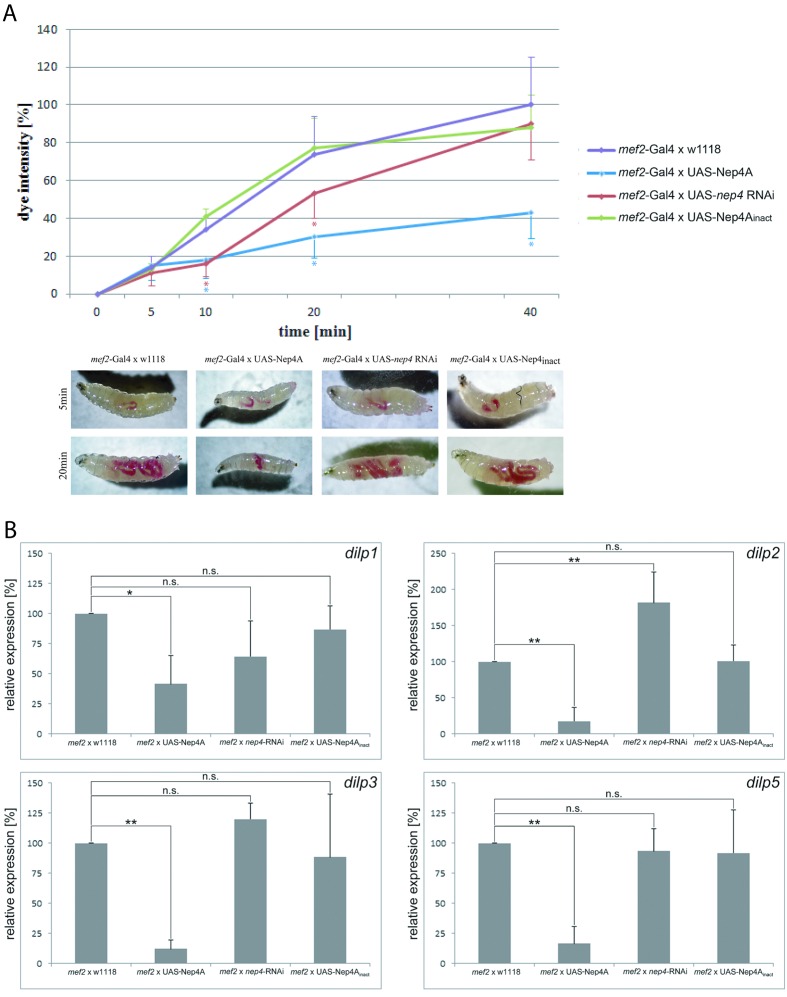
Muscle-specific modulation of nep4 expression affects food intake and dilp expression in transgenic third instar larvae.(A) The genotype-specific rates of food intake are depicted as percentages (%) relative to the intake in control specimens (mef2-Gal4 x w1118) after 40 min of feeding, which was set to 100%. While nep4 knockdown animals (mef2-Gal4 x UAS-nep4 RNAi) exhibited reduced food intake after 10 and 20 min of feeding, Nep4A overexpression animals (mef2-Gal4 x UAS-Nep4A) were characterized by reduced intake throughout the whole measurement (up to 40 min). Animals overexpressing catalytically inactive Nep4A (mef2-Gal4 x UAS-Nep4Ainact) did not exhibit any significant changes in food intake, when compared to controls. Values represent the mean (± s.d.) of at least six independent biological replicates. Asterisks indicate statistically significant deviations from controls (*p<0.05, one-way ANOVA with pairwise comparisons). The lower panel depicts representative images of the genotype-specific food intake at the indicated time points. (B) Changes in the expression of selected dilp genes are presented as percentages (%) relative to expression in control specimens (mef2-Gal4 x w1118), which was set to 100%. Muscle-specific overexpression of Nep4A (mef2 x UAS-Nep4A) reduced the expression of every dilp gene analyzed, while nep4 knockdown in the same tissue (mef2 x nep4-RNAi) resulted in upregulation of dilp2. Animals overexpressing catalytically inactive Nep4A (mef2 x UAS-Nep4Ainact) did not exhibit any significant changes in dilp expression, when compared to controls. Values represent the mean (+ s.d.) of at least three independent biological replicates, each consisting of at least three technical replicates. Asterisks indicate statistical significance (*p<0.1; **p<0.05, one-way ANOVA with pairwise comparisons); n.s. indicates ‘not significant’.DOI:
http://dx.doi.org/10.7554/eLife.19430.00910.7554/eLife.19430.010Figure 3—source data 1.Feeding assay.Depicted are dye intensities (no. of detected pixels) within the intestines of animals of the indicated genotype. At least six individuals per genotype and time point were analyzed. P values marked in bold indicate statistically significant deviations from the respective controls.